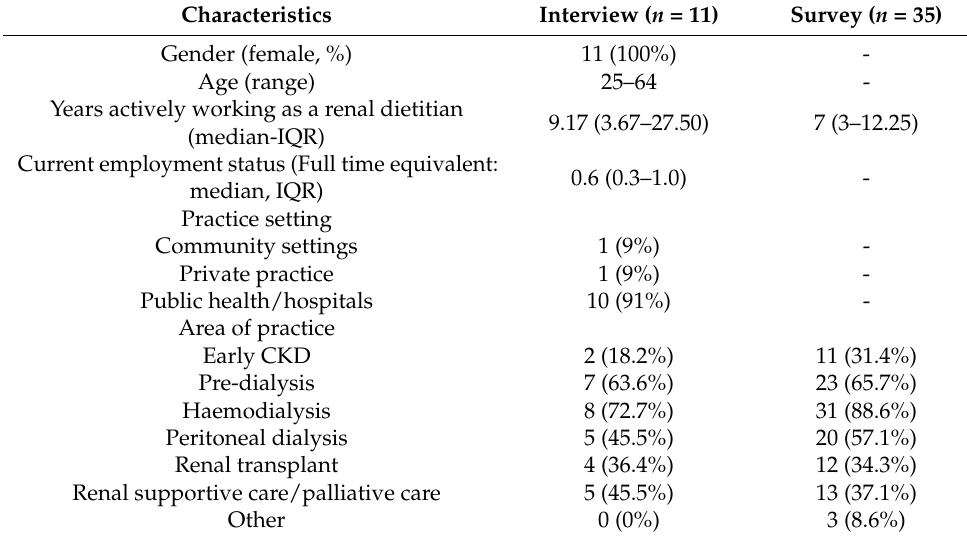
Table 1. Demographic characteristics of the study